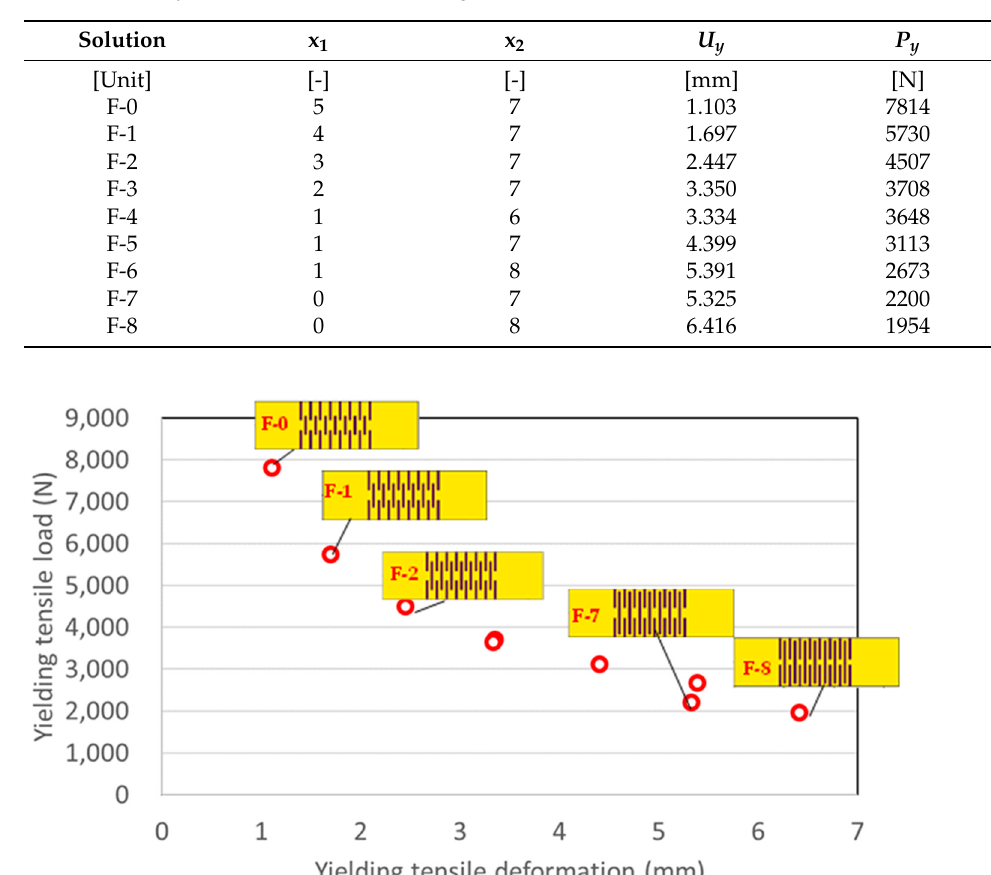
Figure 9. Von Mises stress distribution by FEM analysis with 2.5 mm grid elements (F-8).